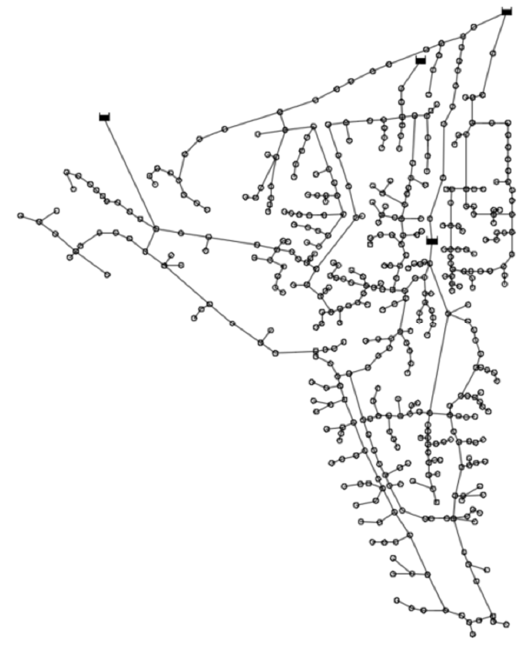
Figure 9. Layout of the Balerma network.